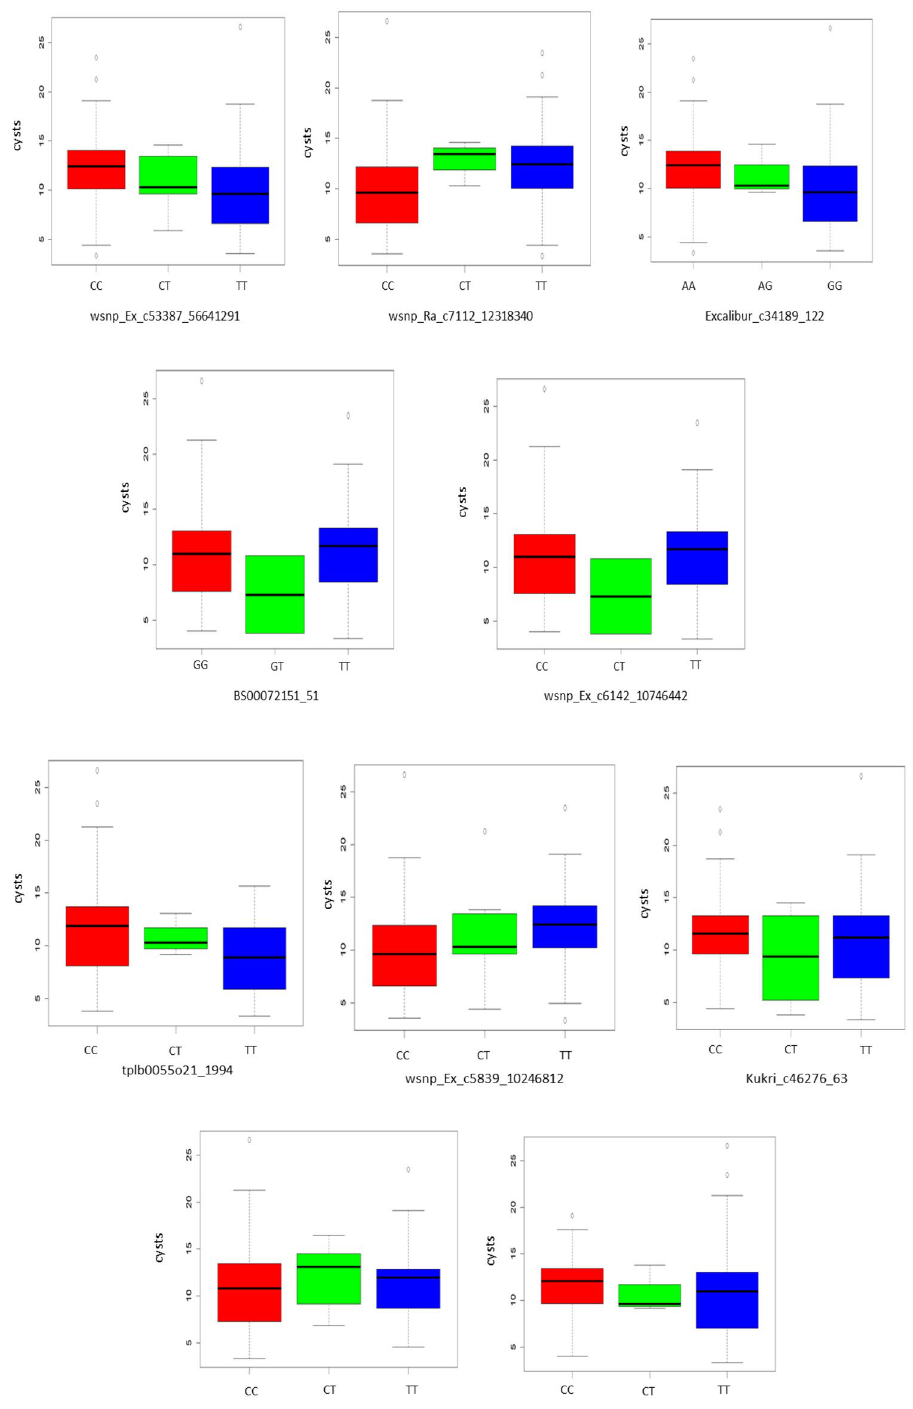
Figure 5. Boxplots showing the allelic effect of ten significant MTAs identified using all 180 wheat accessions and combined environment data, contributing to resistance or susceptibility for H. avenae. X-axis representing the marker name and alleles, Y-axis describes the cysts